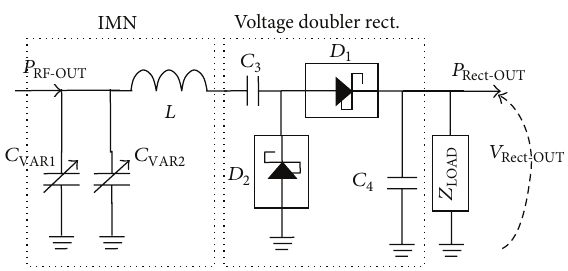
Voltage doubler rect.IMN